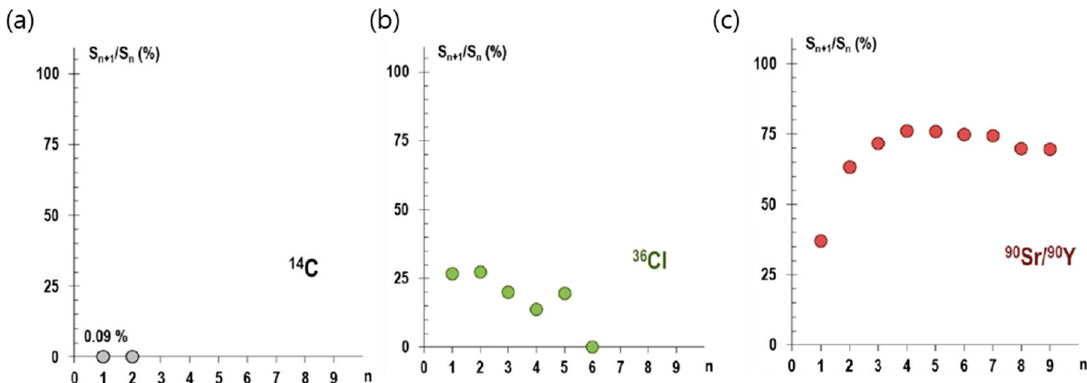
Figure 31. Signal discrimination ratio with radiation exposure time of the radioisotope ( a ) 14 C, ( b ) 36 Cl, ( c ) 90 Sr / 90 Y discrimination ratio [97].